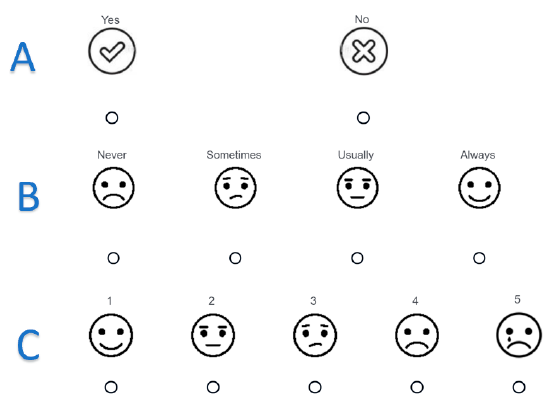
Figure 1. An example of the Likert scale used in the younger children’s version of the survey inter ‐ face; A : yes/no question, B : never/sometimes/usually/always question, C : 1 to 5 frequency